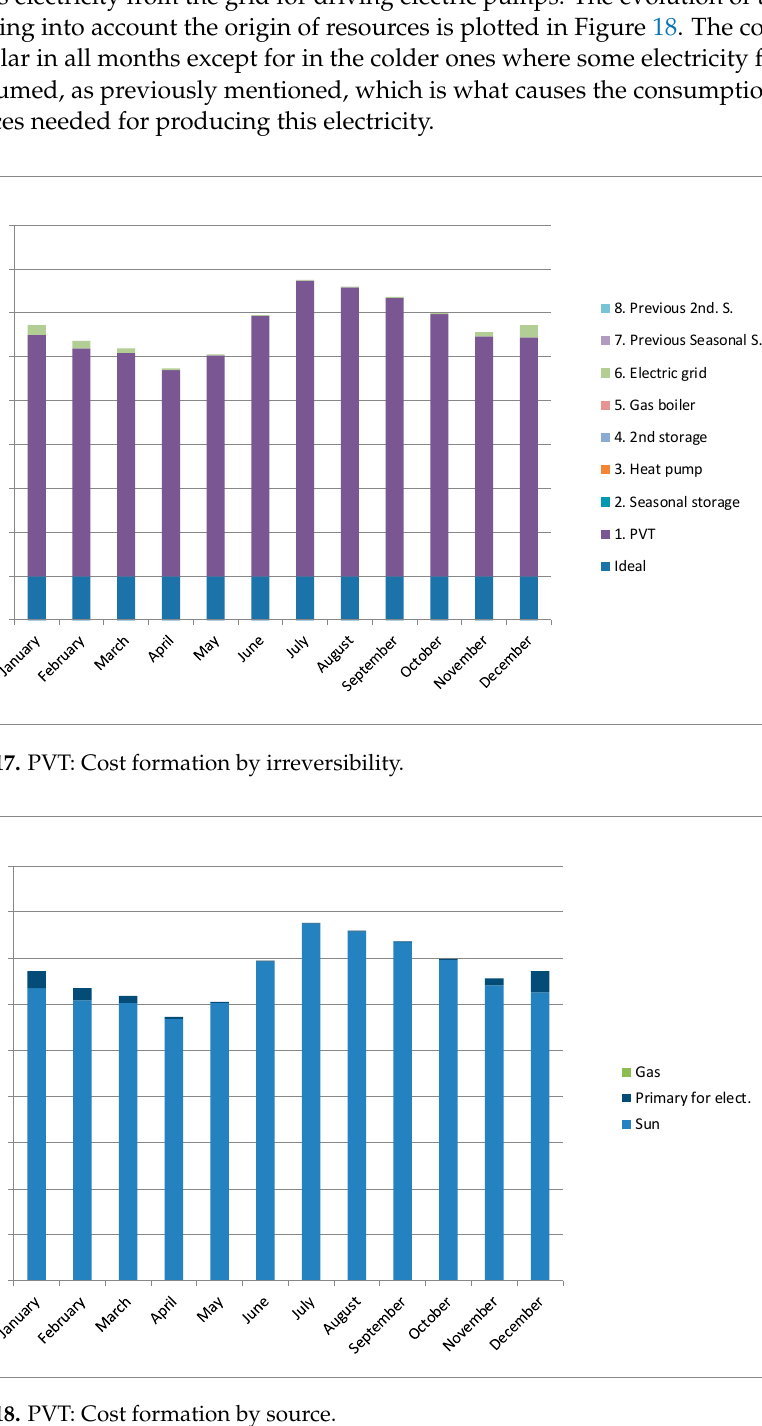
Figure 16. Cost formation by source: Year basis.